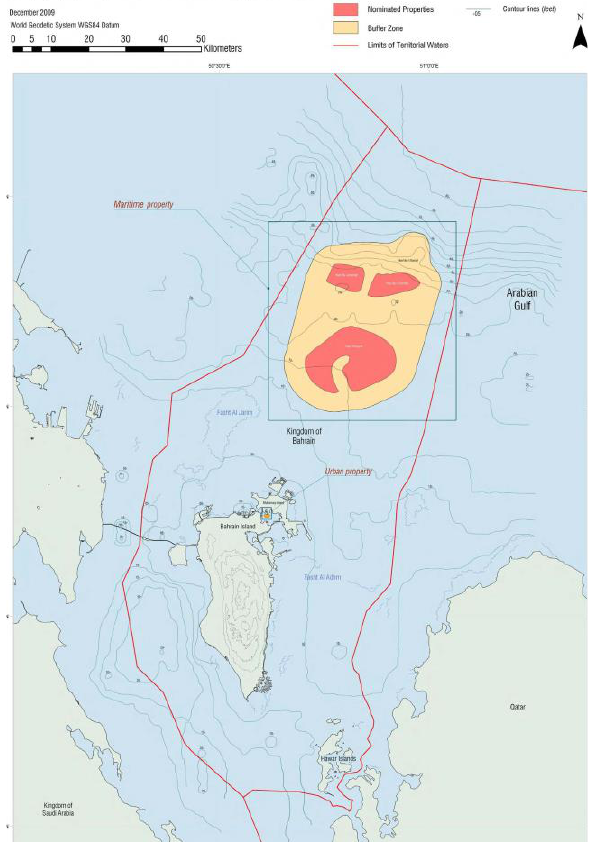
Figure 2 Map showing the location of Bahrain and its territorial waters in the Arabian Gulf as well as the core and the buffer zone of the Pearling, Testimony of an Island Economy UNESCO